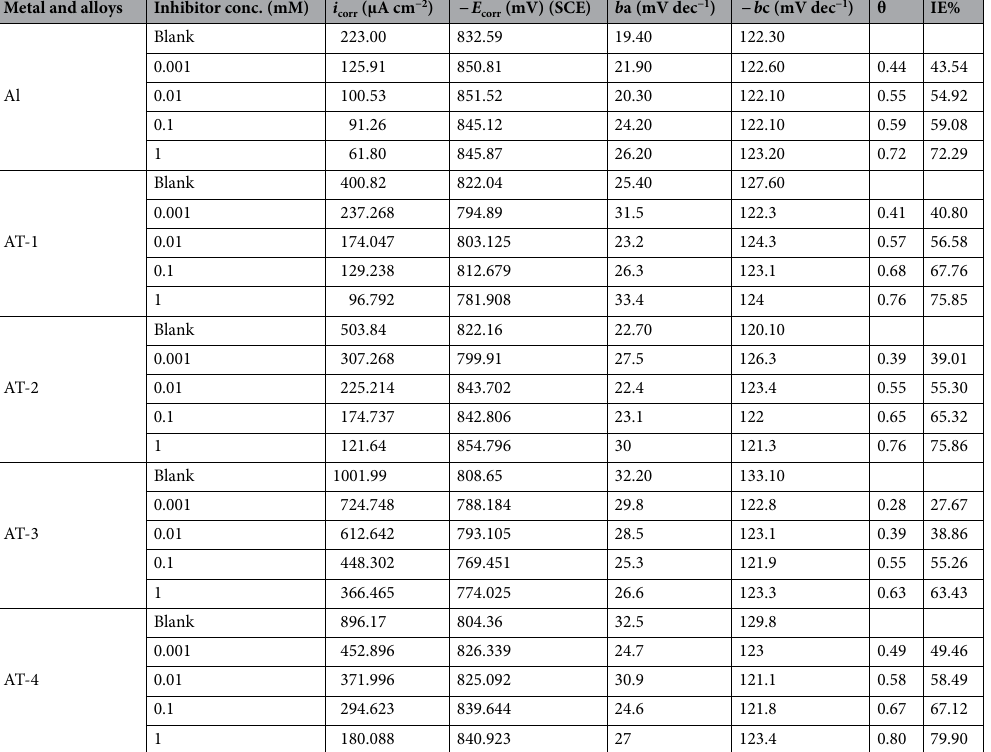
Table 2. Corrosion parameters of pure Al, AT-1, AT-2, AT-3, and AT-4 alloys after 30 min of exposure to 0.5 M HCl solution comprising different concentrations of 2-MBT inhibitor at a temperature of 25 °C.